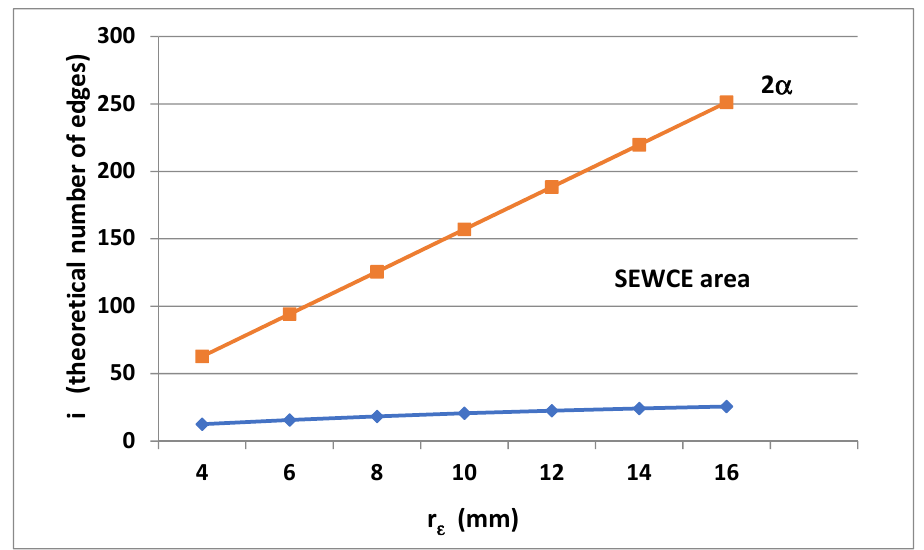
Figure 7. Example of SEWCE area for a round insert: 2 < r ε < 16, for f = 0.4 mm/rev and a p = 0.4 mm.